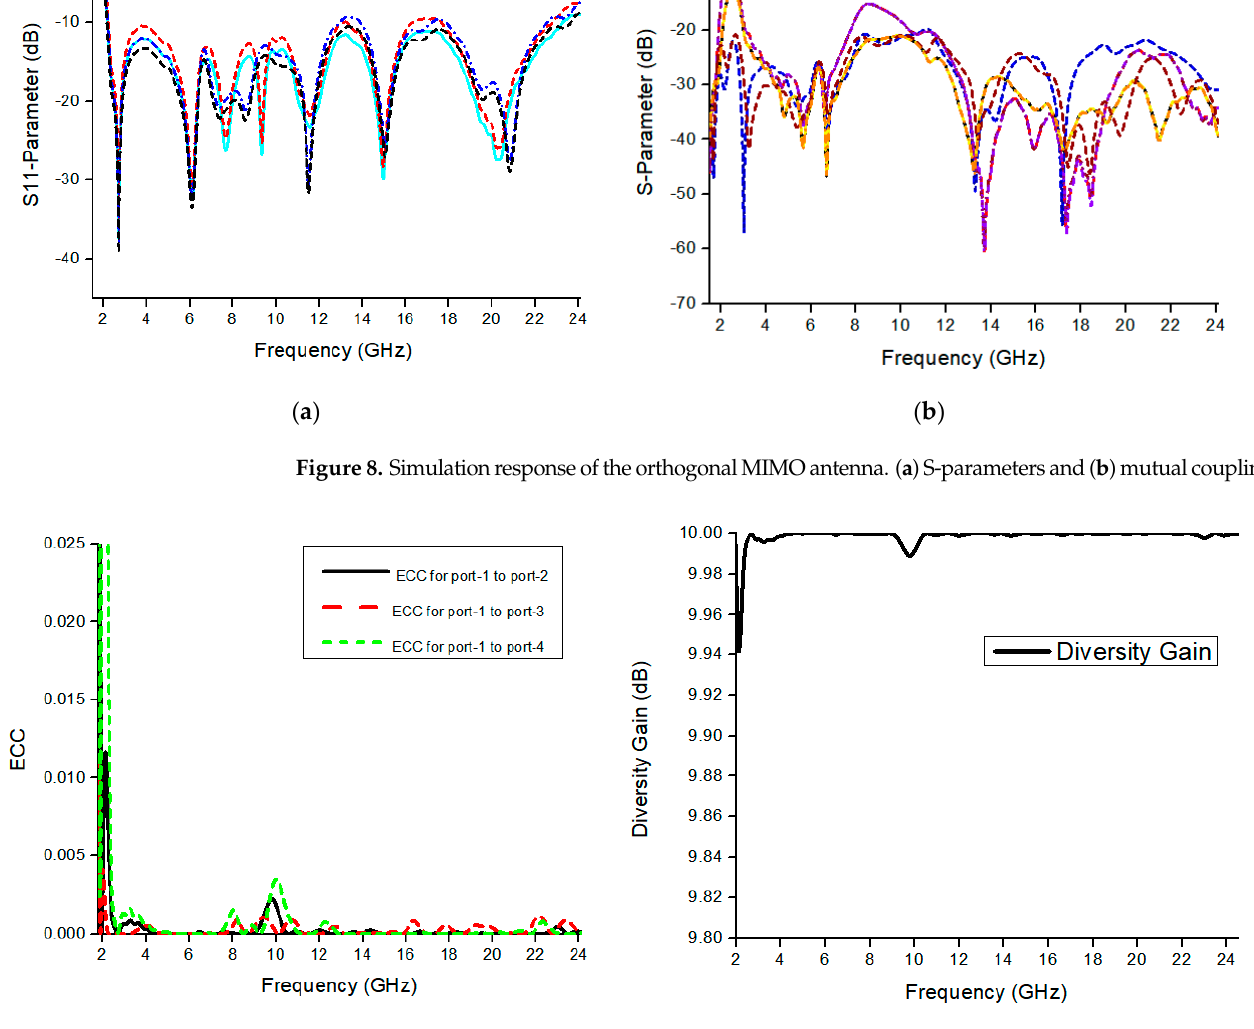
Figure 9. Simulation response of the orthogonal MIMO antenna. ( a ) ECC and ( b ) diversity gain.